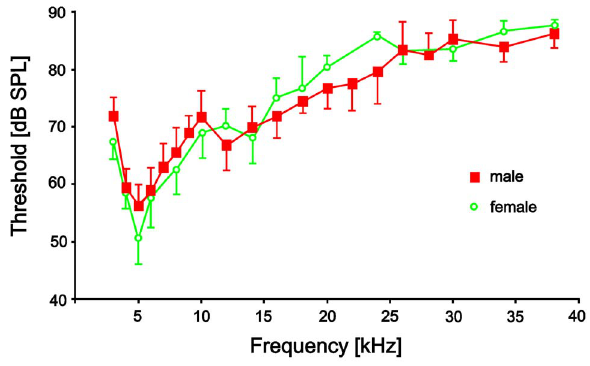
Figure 2. Hearing thresholds (mean and s.e.m.) of female (green) and male (red) E. auditrix . The hearing threshold was determined based on extracellular recordings from the neck connective. Hearing threshold for female adapted from [17]. N=3 for female, N=4 for male.